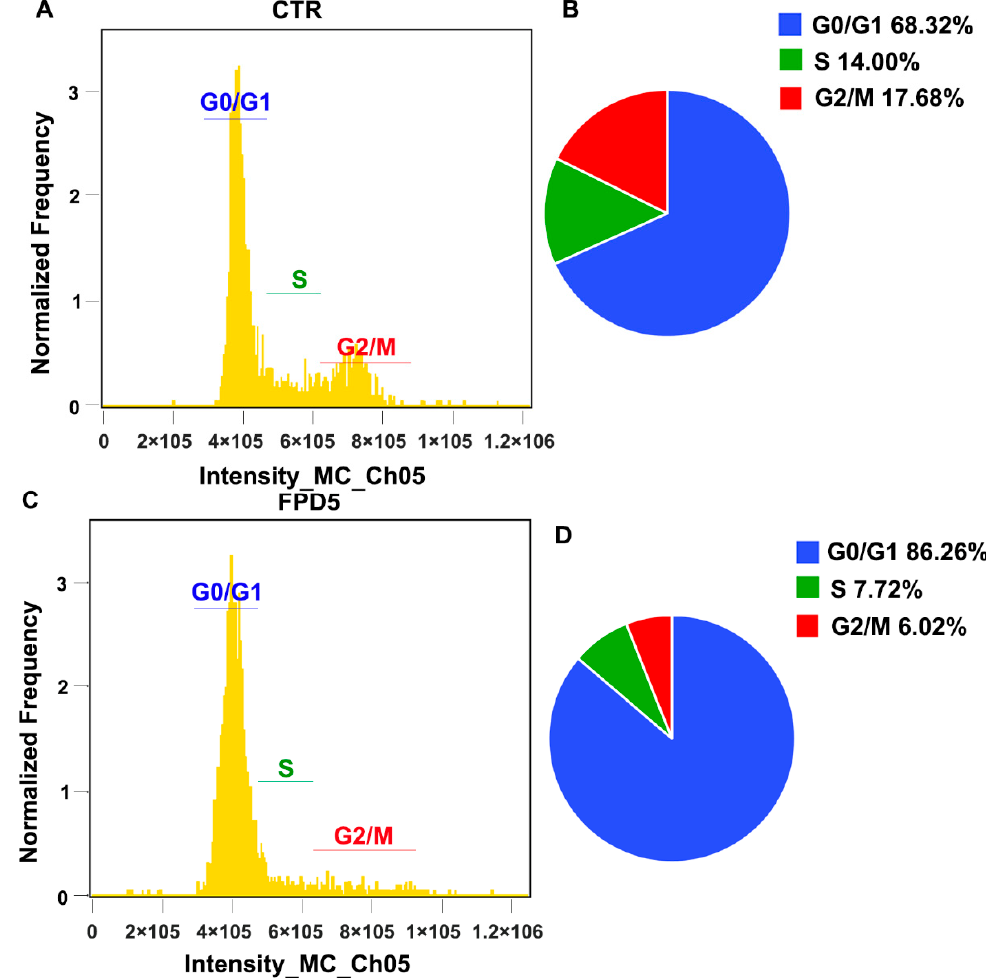
Figure 4. FPD5 arrested the cell cycle of A549 cells at G0/G1 phase. ( A – D ) After treatment with 5 µ M FPD5 for 24 h, A549 cells were collected and stained with PI, and flow cytometry was performed to analyze the changes in the proportion of cells in each stage of the cell cycle. n = 3.